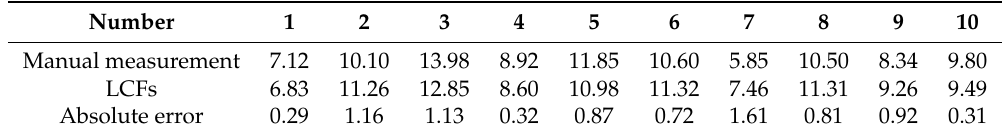
Table 2. Experimental results of ice thickness (mm).